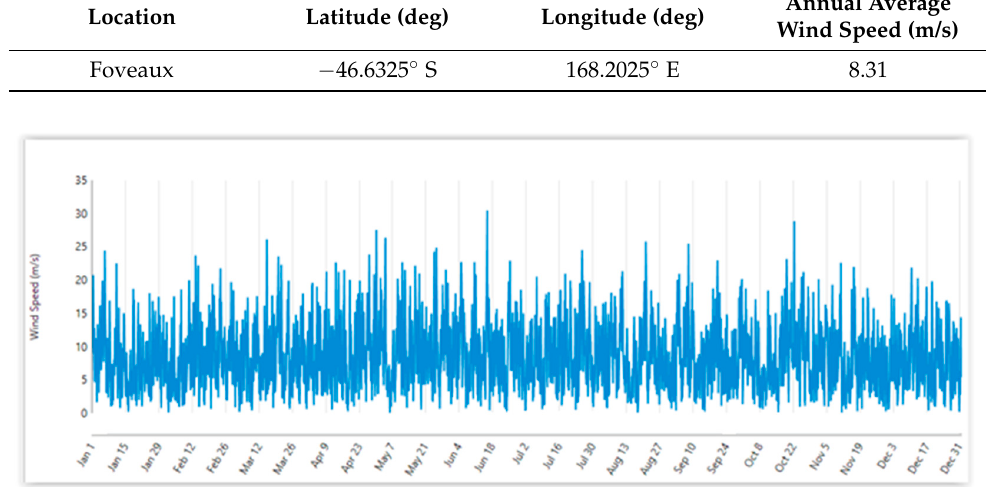
Figure 5. Wind conditions near Stewart Island ( left ) and at the Foveaux site ( right ) [16]. The environmental parameters of the site are summarised in Table 2 and Figure 6. Table 2. The environmental parameters of the Foveaux site.